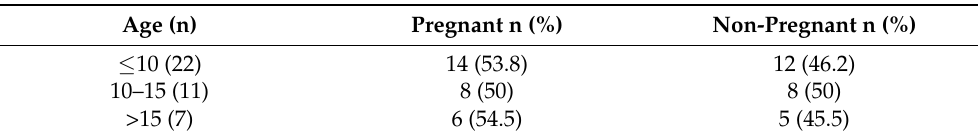
Table 2. Per cycle pregnancy rate in pregnant and non-pregnant mares divided into groups according to